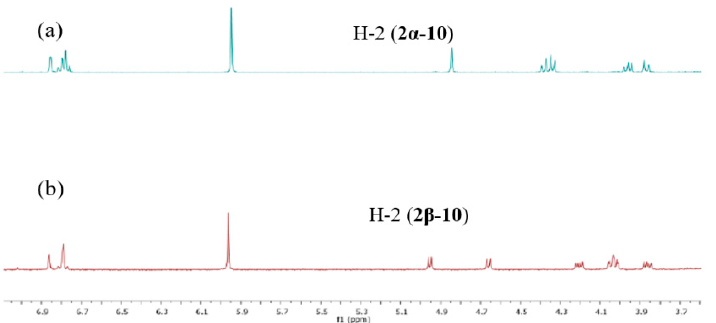
Figure 7. Overlaid 1 H NMR spectra of ( a ) 2 α -10 occurred from the starting 2 β -10 treated with CD 3 OD and TFA- d 1 for 10 min and ( b ) the starting 2 β -10 .